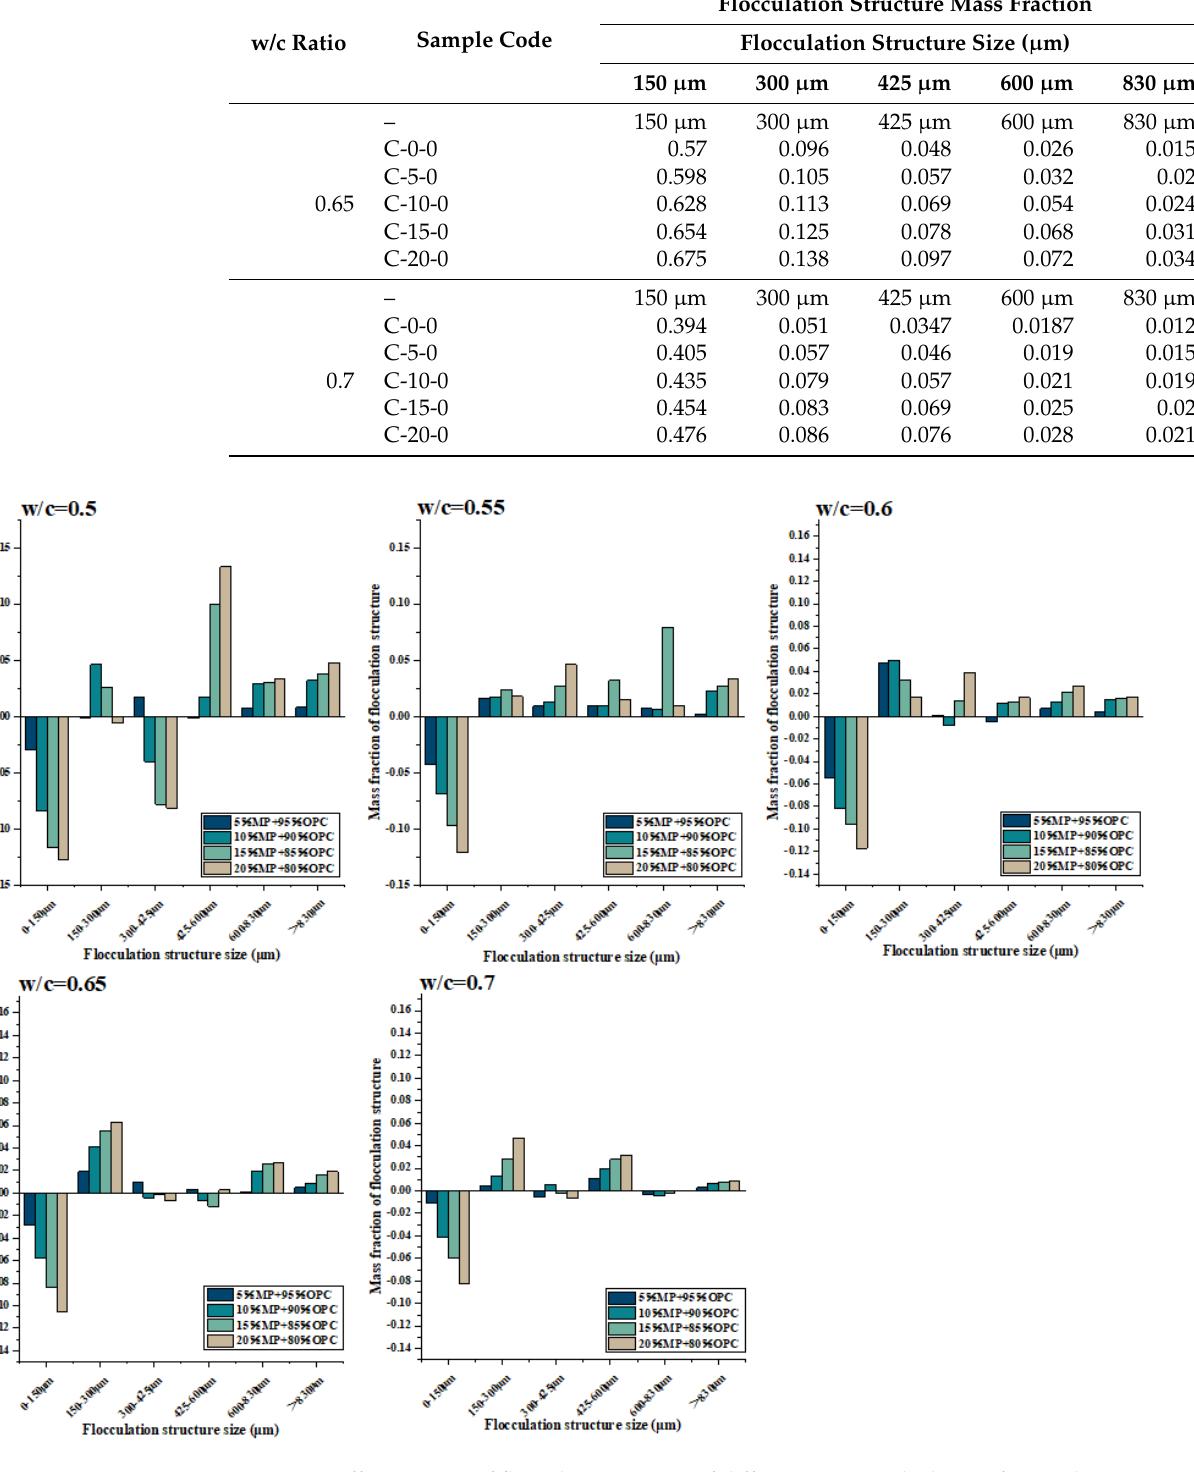
Figure 9. Differentiation of flocculent structure of different sizes on the basis of control cementitious suspension at different MP contents.